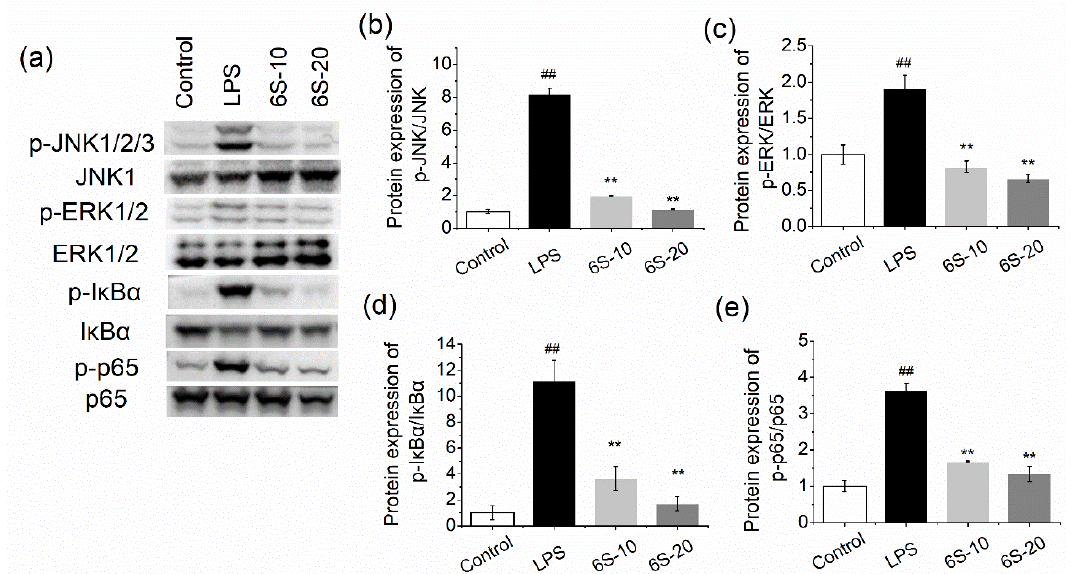
Figure 7. 6-Shogaol inhibited MAPK/NFκB pathway in LPS-treated BRL-3A cells. The cells were pretreated with 6-shogaol for 2 h before being treated with LPS (0.1 µ g/mL) for 0.5 h: ( a ) the blots; ( b ) protein expression of p-JNK/JNK; ( c ) protein expression of p-ERK/ERK; ( d ) protein expression of p- IκBα/IκBα ; ( e ) protein expression of p-p65/p65. 6S-10, 10 μM of 6-shogaol; 6S-20, 20 μM of 6-shogaol. Data are presented as mean ± SEM ( n = 3). ## p < 0.01 versus control group; ** p < 0.01 versus LPS group.